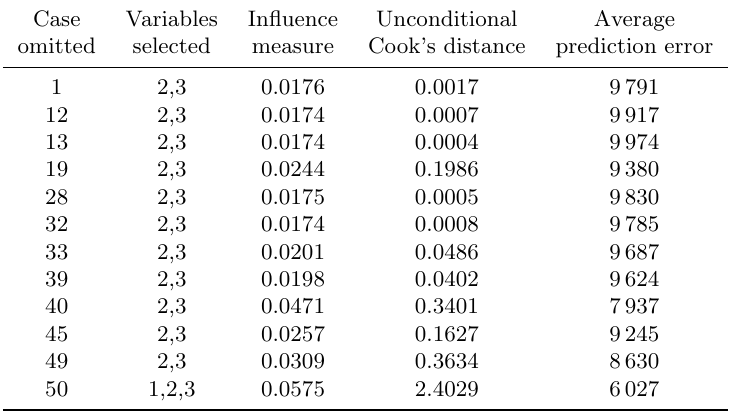
Table 2: Fuel data: Variable selection with AIC